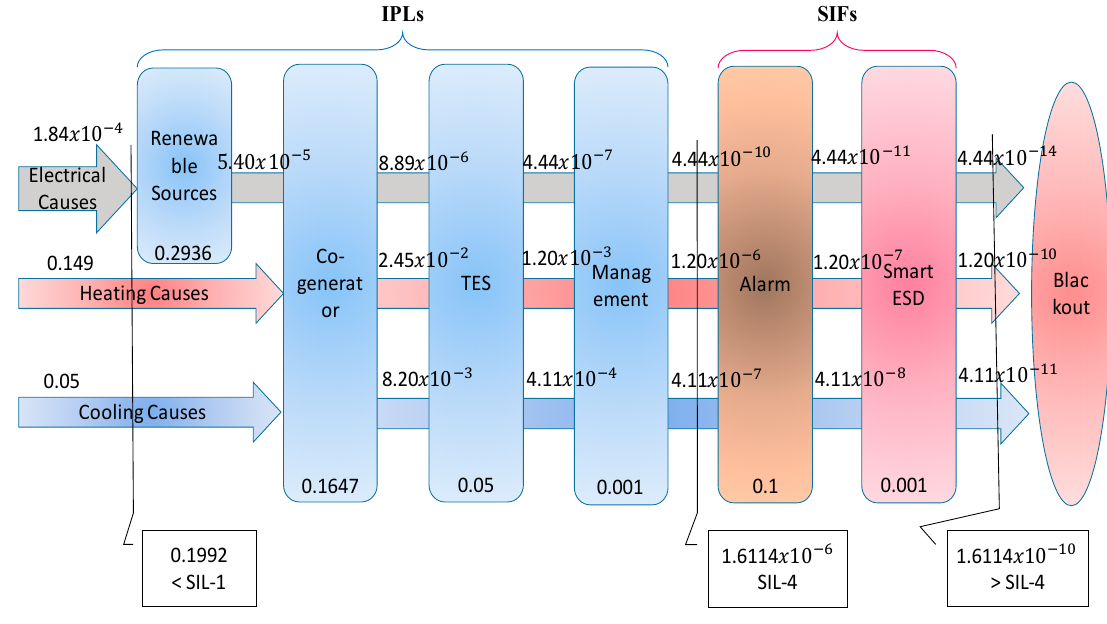
Figure 5. Proposed LOPA path diagram for MEG.